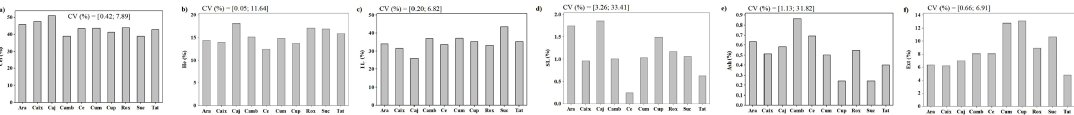
Figure 5. Mean values of wood constituents for all species. (a) Cellulose (Cel); (b) Hemicellulose (He); (c) Insoluble Lignin (IL); (d) Soluble Lignin (SL); (e) Ashes (Ash); (f) Extracts (Ext); present in the 10 species and the lowest and the highest coefficient of variation (CV) values obtained (upper side